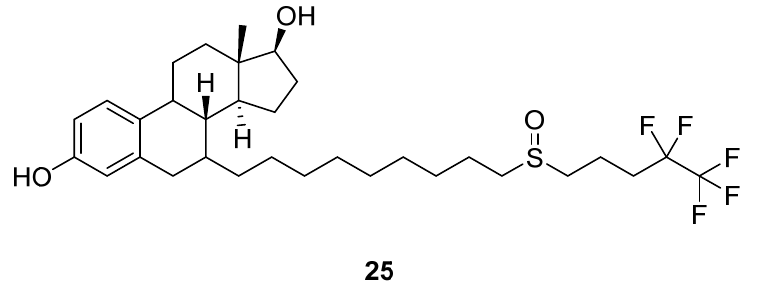
Figure 14. Structure of fulvestrant.